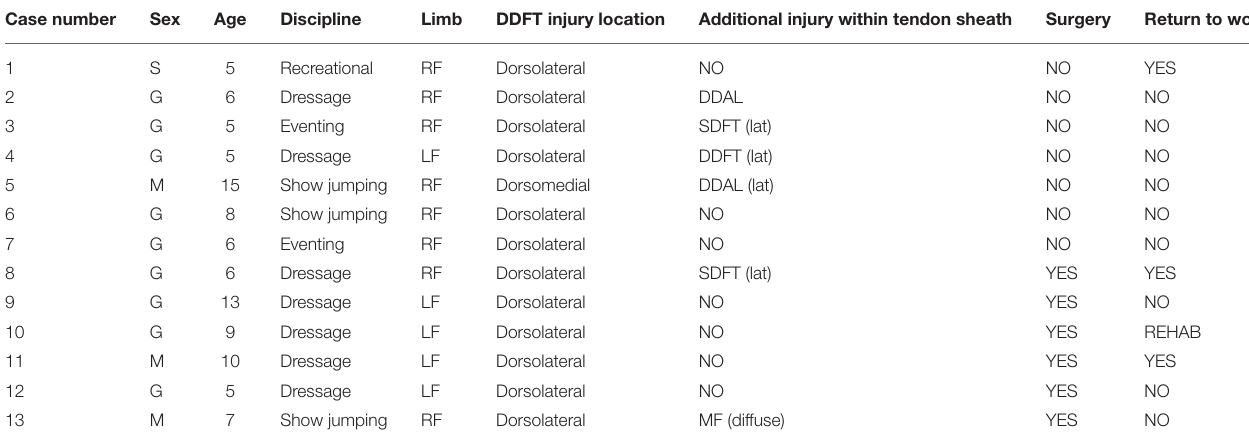
TABLE 2 | Age, sex, use, limb, location of injuries, confirmation during surgery, and ability to return to work of the 13 horses. Case